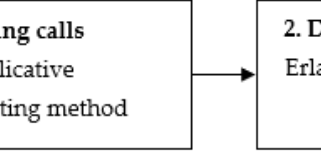
Figure 1. The existing workforce planning method.